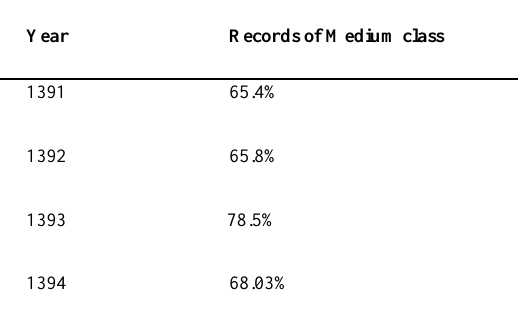
Table 9. Ayandeh Bank performance.